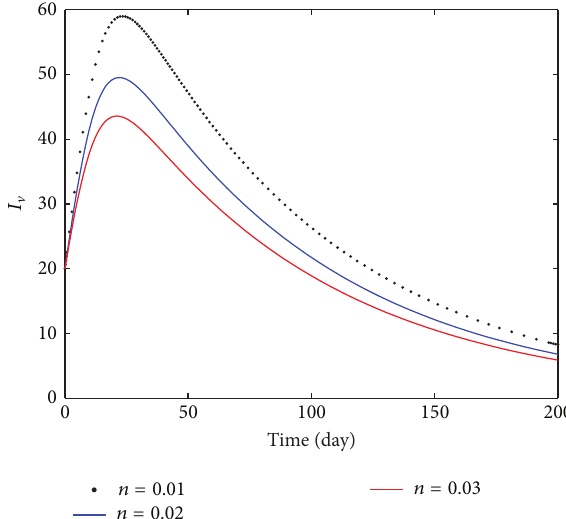
Figure 1: Plot of the exposed host population.